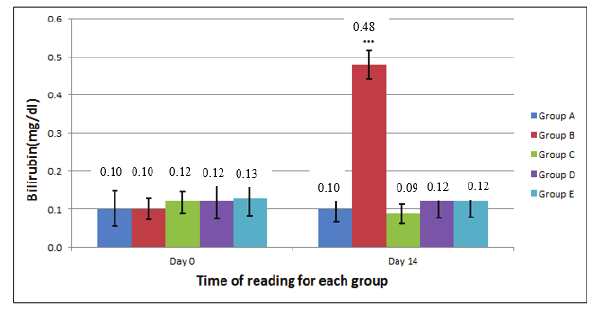
Fig-4 : Effect of Ajwa date on serum bilirubin level (mean ± SD) of ATT induced hepatotoxic rabbits (n=6) Group A: Normal Control, Group B: Anti-tuberculous drugs (ATT), Group C: ATT + Whole Ajwa Date, Group D: ATT + Ajwa Date Flesh, Group E: ATT + Ajwa Date Seed